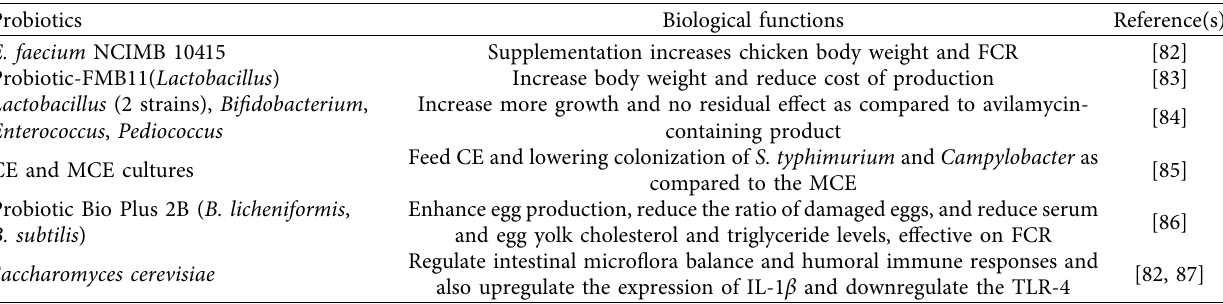
Table 1: Probiotics and beneficial